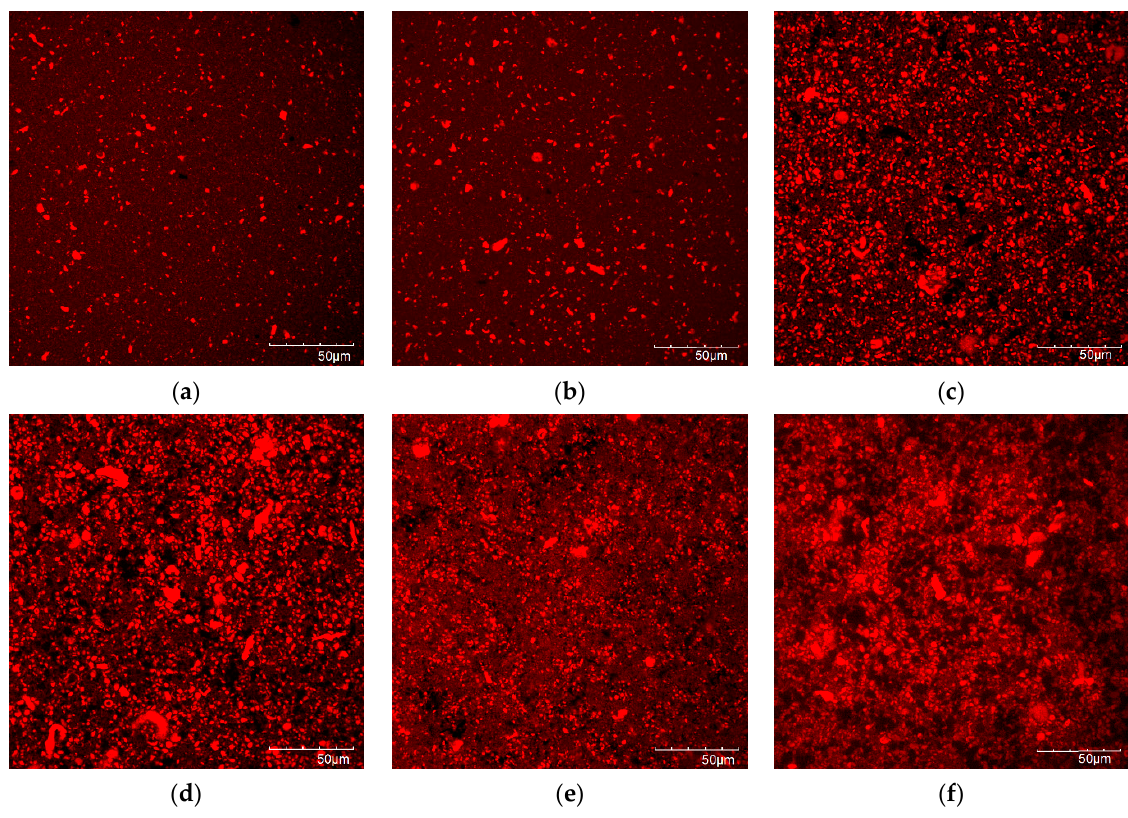
Figure 6. CLSM images of the unfermented and fermented samples. Nile Blue was used to stain the protein, shown in red. ( a ) unfermented sample with fructose, ( b ) unfermented sample with sucrose, ( c ) Yoflex control, ( d ) LcTR116, ( e ) LpMP070, ( f ) Lbp6.1.